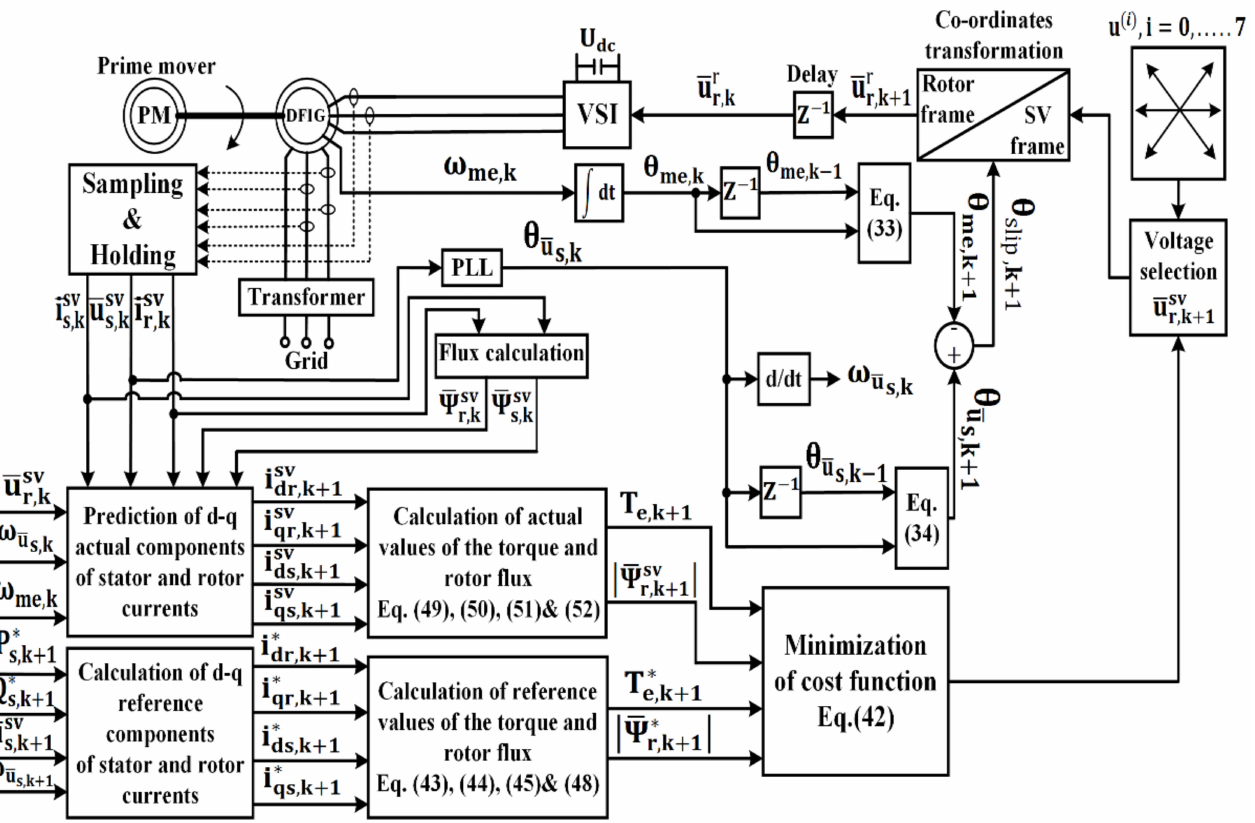
Figure 7. MPDTC technique for the